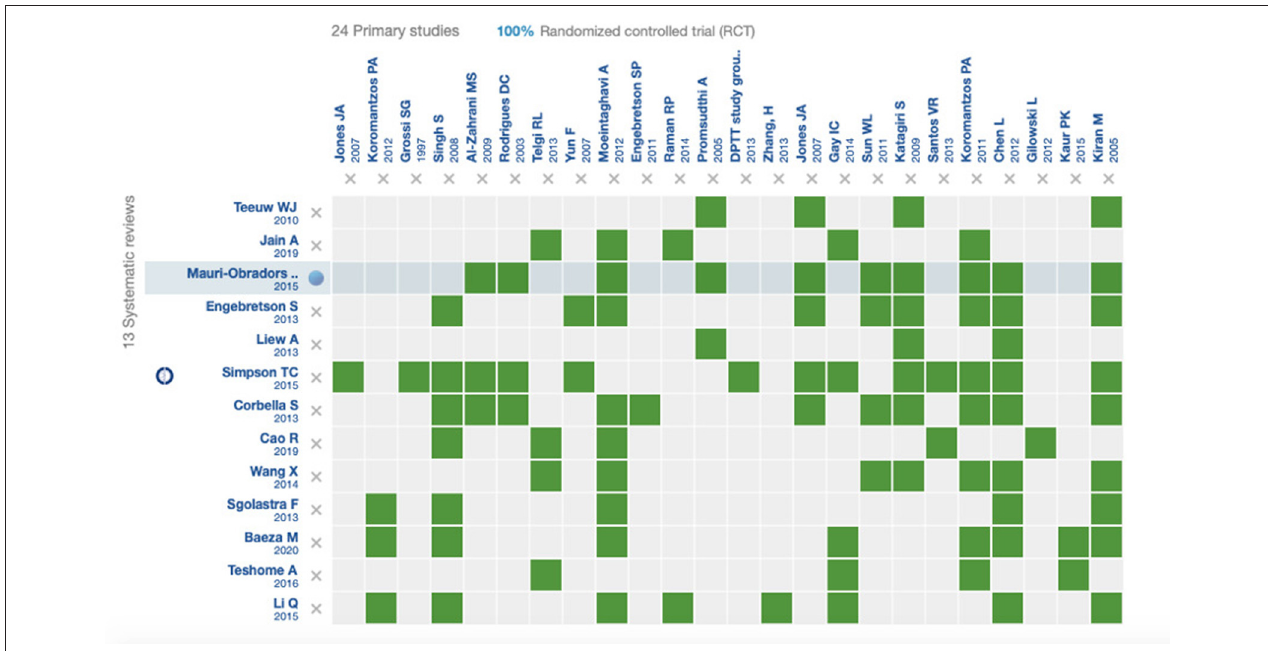
FIGURE 1 | Evidence matrix including the systematic reviews answering question 3, and their respective randomized clinical